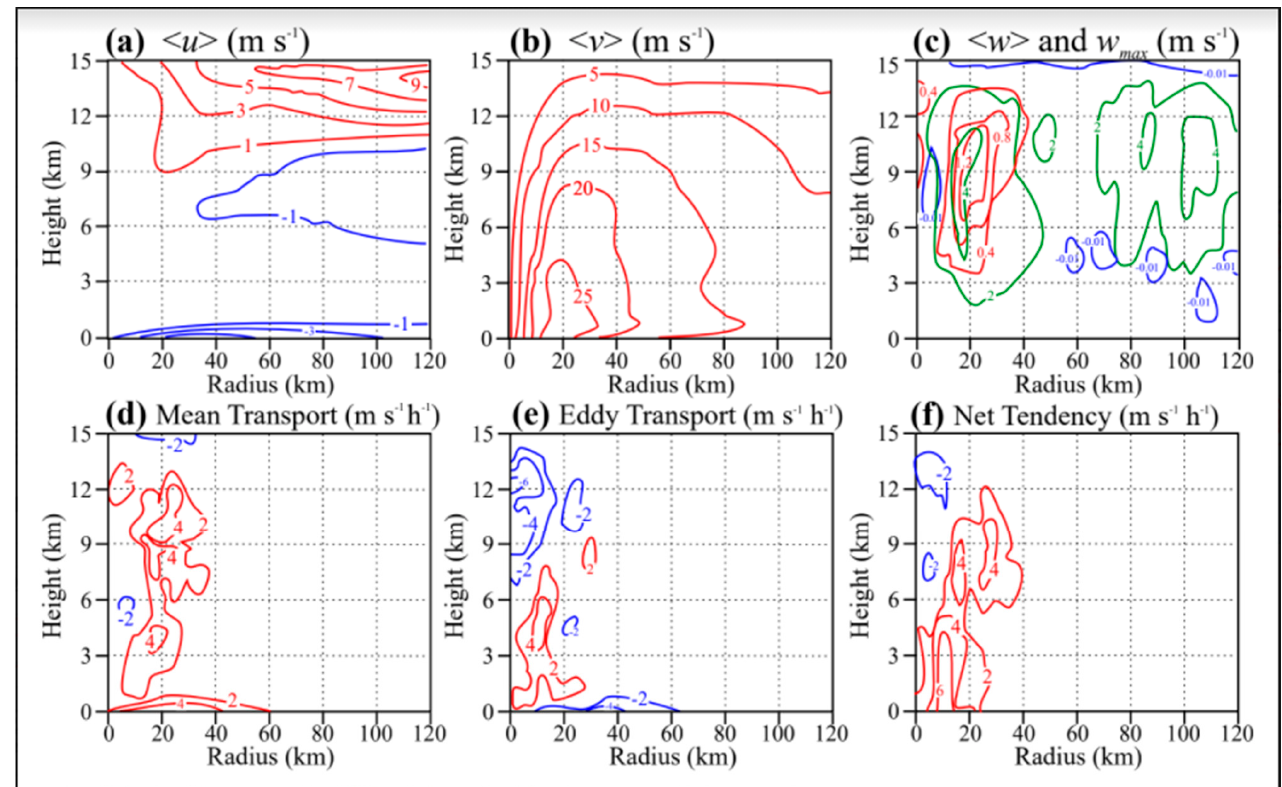
Figure 12. Radius-height momentum ( a – c ) and momentum tendency ( d – f ) from a 12 h HWRF forecast of Hurricane Irma. Shown: ( a ) radial velocity (contour interval of 2 m s − 1 ); ( b ) tangential velocity (contour interval of 5 m s − 1 ); ( c ) vertical velocity (red contour interval of 0.4 m s − 1 for positive velocities and blue contour interval of 0.01 m s − 1 for negative velocities) and maximum vertical velocity (green contour interval of 2 m s − 1 ); ( d ) sum of the mean radial influx of absolute vertical vorticity and the mean vertical advection of the mean tangential momentum (contour interval of 2 m s − 1 h − 1 ); ( e ) sum of the eddy radial vorticity flux, the eddy vertical advection of eddy tangential momentum, the vertical diffusion, and the horizontal diffusion (contour interval of 2 m s − 1 h − 1 ); and ( f ) net tangential wind tendency (contour interval of 2 m s − 1 h − 1 ). All red/blue contours represent positive/negative azimuthally averaged fields. Green contours in ( c ) represent the maximum vertical velocity over all azimuths. All fields are temporally averaged over a 1 h period centered on the forecast hour. The y -axis represents height from 0–15 km, and the x -axis shows radius from 0–120 km.